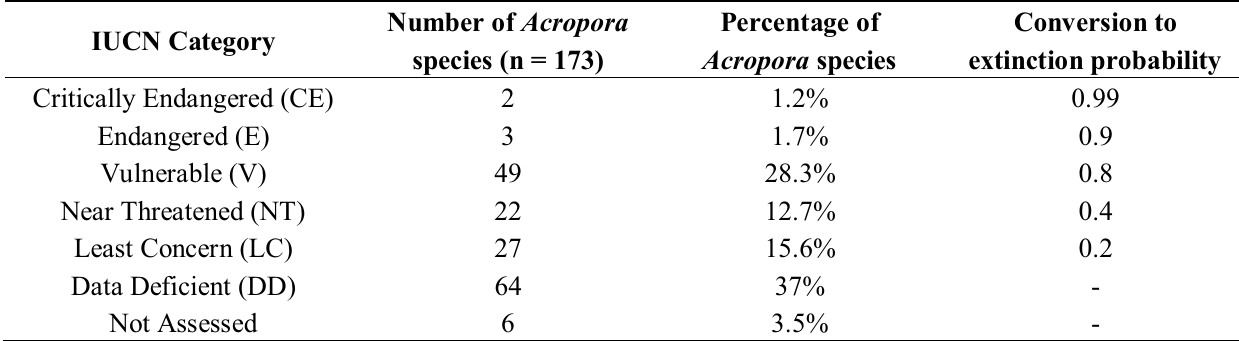
Table 1. Number of species in the different IUCN categories of threat according to [23]. Conversion to extinction probability follows